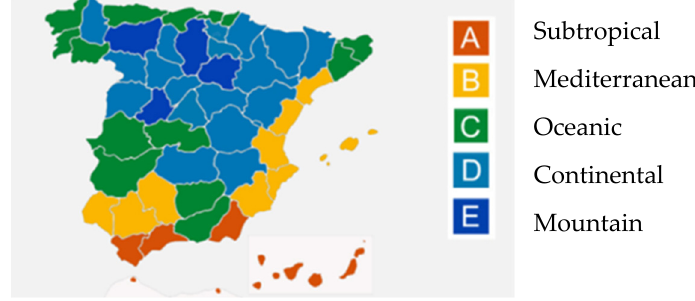
Figure 8. Climatic Zones in Spain.